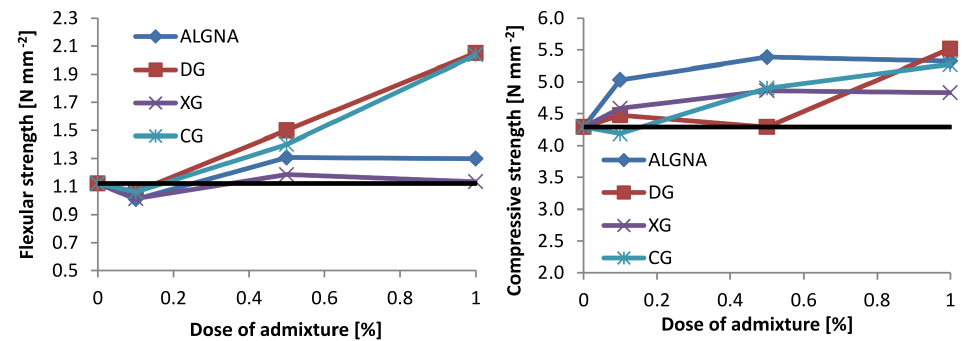
Figure 3. Flexural and compressive strength of mortar specimens 28 days old.